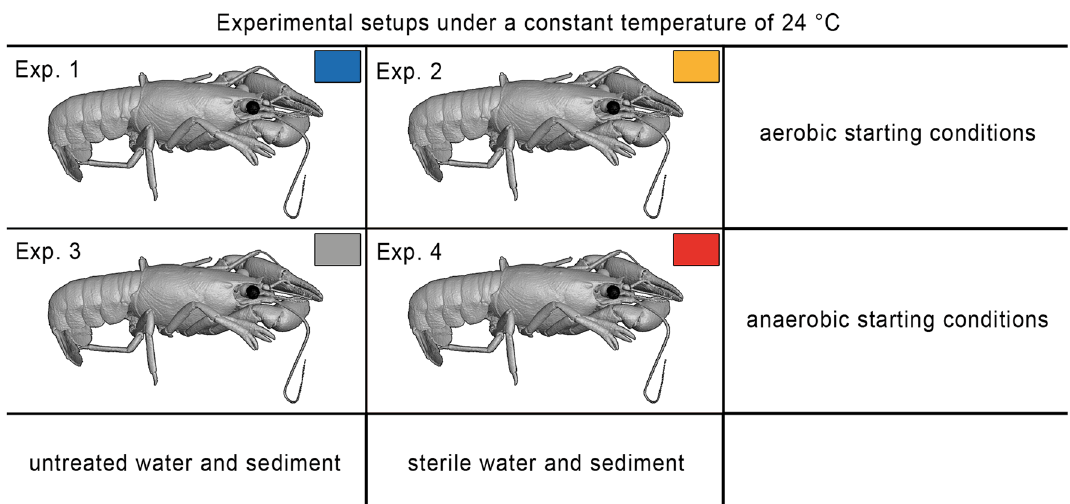
Figure 1. Experimental setup design conducted at a constant temperature of 24 °C. Exp. 1 was conducted under aerobic conditions with untreated water and sediment. Exp. 2 was conducted under aerobic conditions with sterile water and sediment. Exp. 3 was conducted under anaerobic conditions with untreated water and sediment. Exp. 4 was conducted under anaerobic conditions with sterile water and